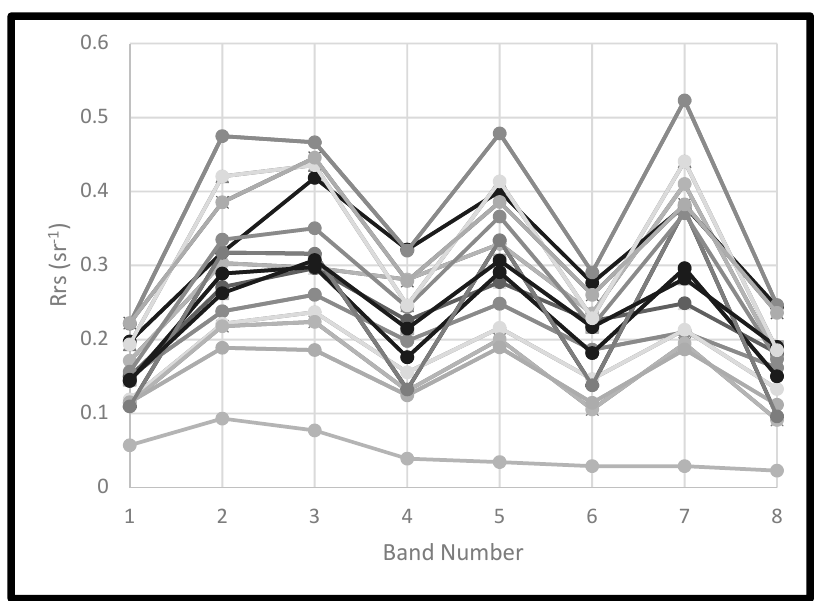
Figure 3. Spectral signatures of a sample of glinted pixels (upper, multiple), and the spectral signature of a glint-free pixel from the same scene (lower, single).